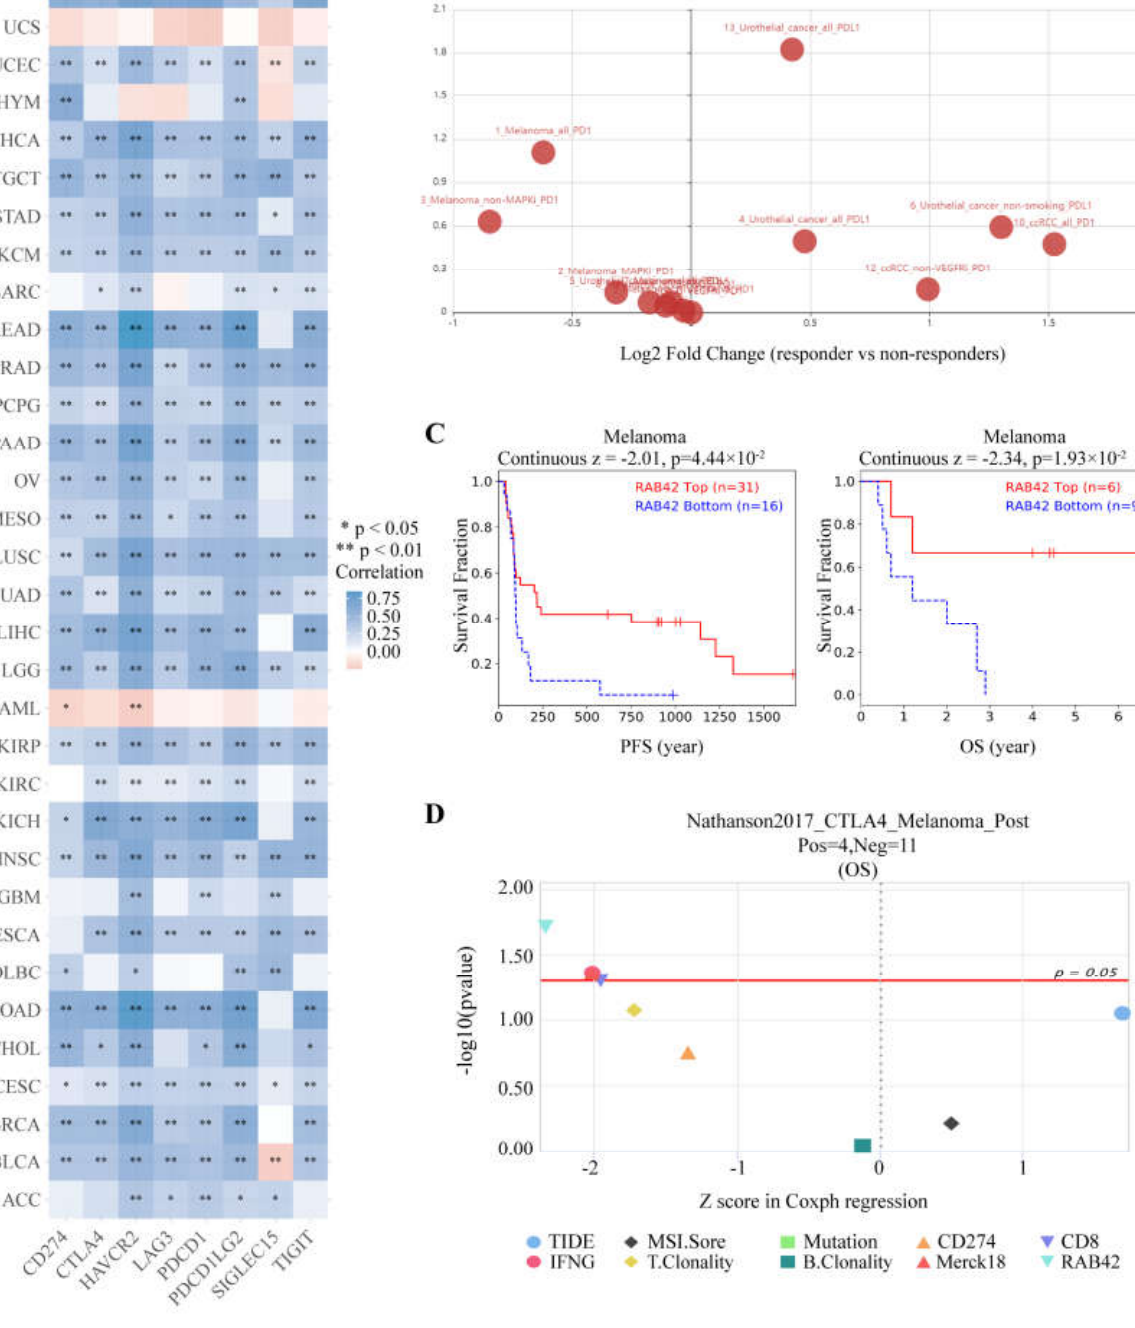
Figure 7. RAB42 was a predictor for immunotherapy. ( A ) Spearman’s correlation between RAB42 and immune checkpoint genes expression in the ACLBI database. ( B ) Differences in RAB42 expression among responders and non-responders treated with PD1/PD-L1 inhibitors using the TISIDB database. ( C ) The effect of RAB42 expression on the prognosis of melanoma patients treated with PD1 or CTLA4 inhibitors using the TIDE database. ( D ) Predictive value of RAB42 for immunotherapy using the TIDE database. * p < 0.05; ** p < 0.01.